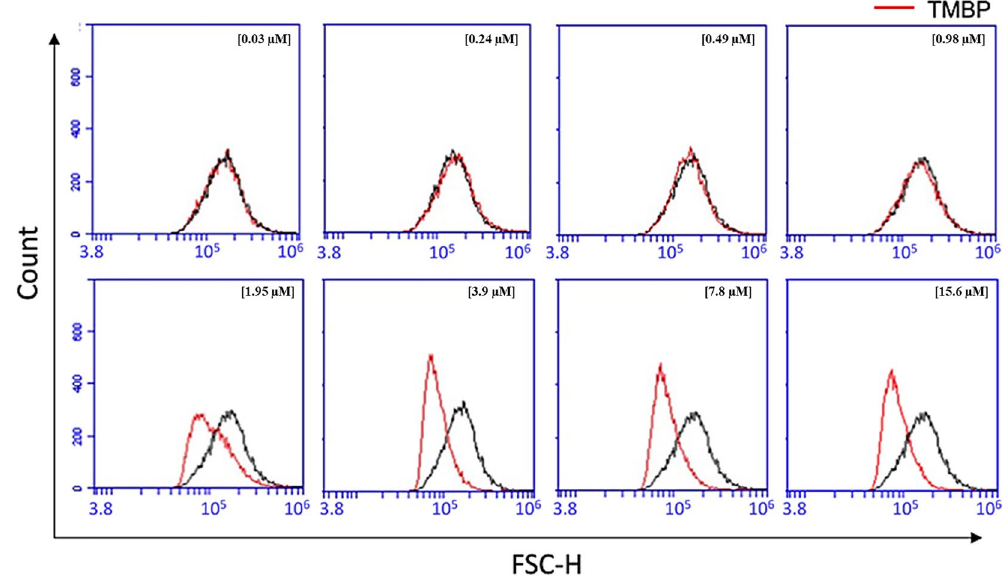
Figure 3. Cell size on promastigote forms from L. amazonensis treated with TMBP for 24 h. FSC-H was used to assess cell size at each of the concentrations of TMBP (0.03 to 15.6 µM). Black lines are the control group (non- treated parasites), and the red-line area corresponds to the treated